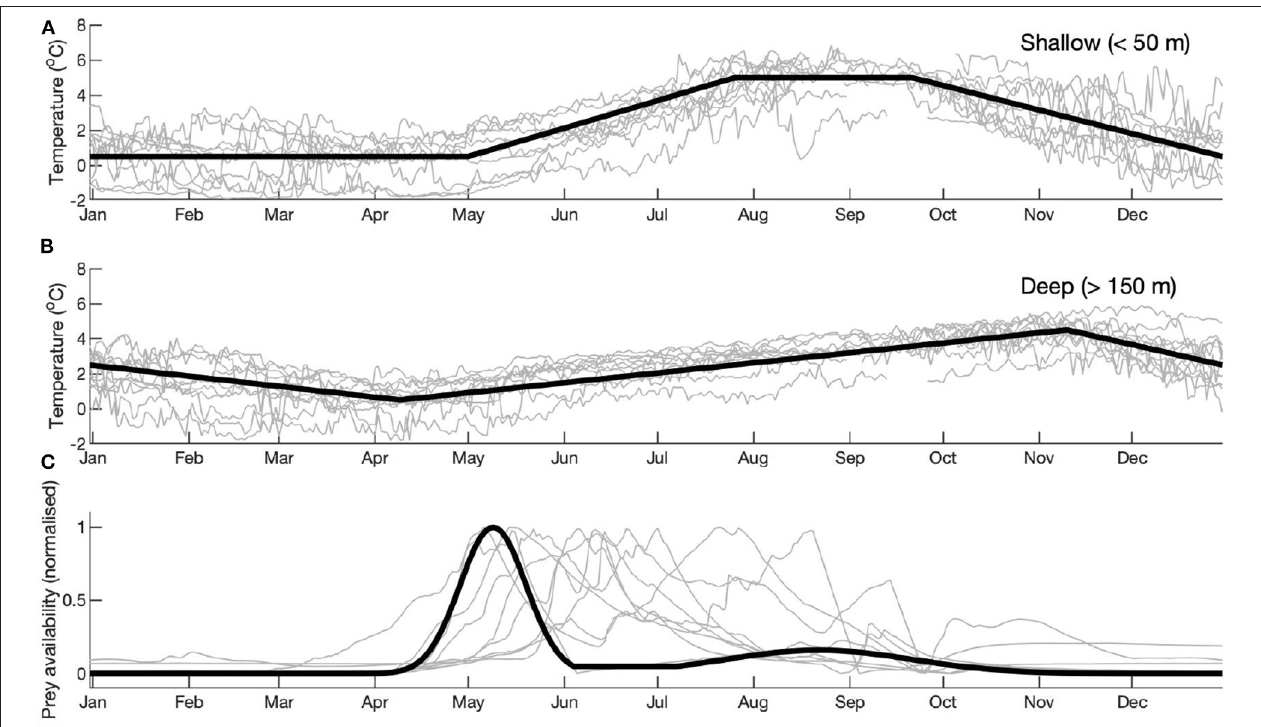
FIGURE 2 | Time series from 10 years of mooring measurements for (A) shallow ( < 50 m) temperature; (B) deep ( > 150 m) temperature; (C) normalized fluorometry. Time series representing the full 10 years are plotted in bold lines. In (A,B) , these time series are based on the averages of all 10 years. This was not possible for fluorometry (C) due to large inter-annual variability. Instead, an idealized model forcing has been created based on 1 year (2006), and inter-annual variability is captured by varying the timing of the spring